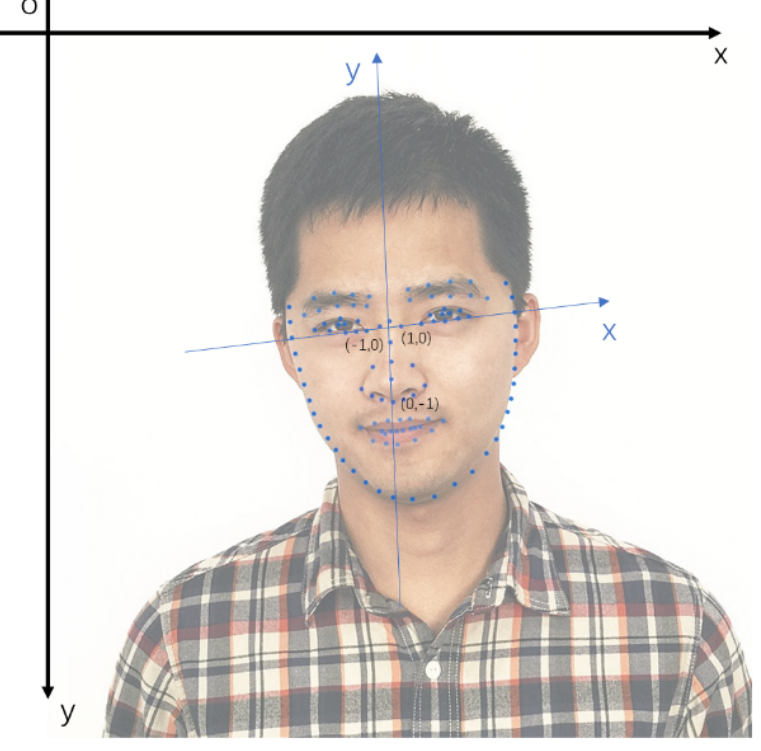
Figure 3. Relative face coordinate system, where the Cartesian, or absolute, coordinate system is represented by the black coordinate system, which was used to record the position of pixels in the image, and the non-Cartesian, or relative, coordinate system is represented by the blue coordinate system, which was used to record the relative position of key points on the face.